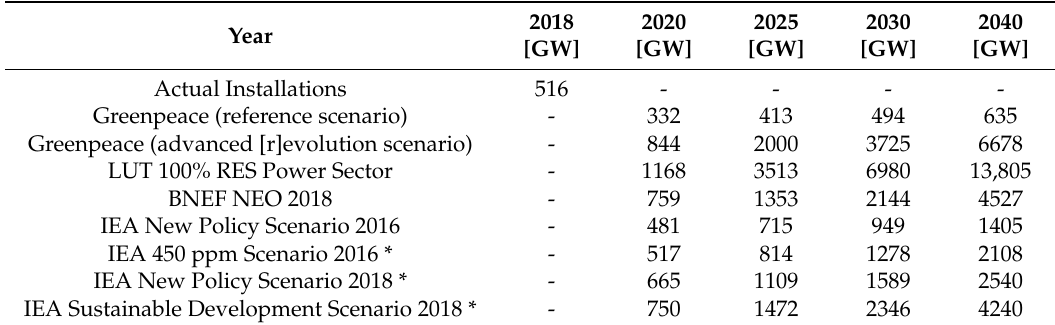
Table 1. Projected evolution scenarios of the world-wide cumulative solar electrical capacities through 2040.